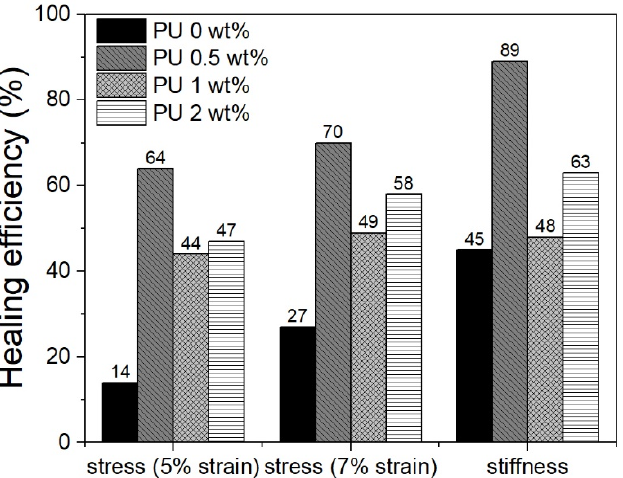
Figure 8. Healing performances of PU cylindrical foams after recovery.